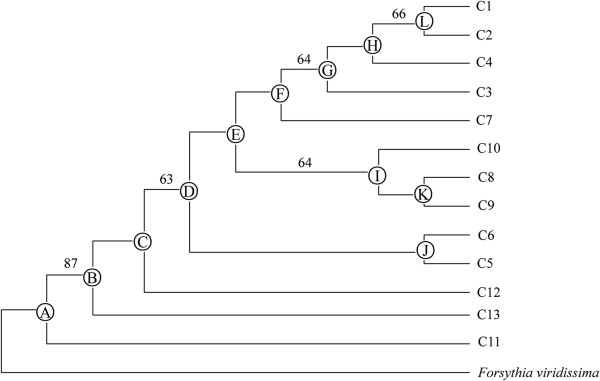
Neighbor-joining (NJ) clustering of thirteen chlorotype sequences of F. suspensa. F. viridissima was used as an outgroup. The bootstrap confidence values (%) are indicated on the branches.